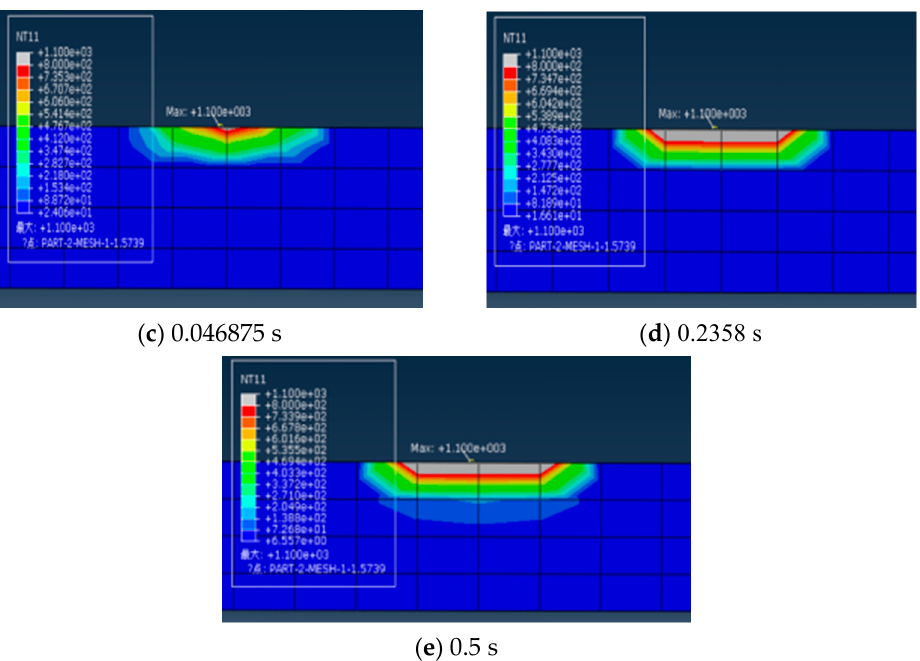
Figure 25. Temperature distribution cloud diagram along the thickness direction at different moments, ( a ) at 0.03125 s, ( b ) at 0.03906 s, ( c ) 0.046875 s, ( d ) at 0.2358 s, ( e ) 0.5 s.